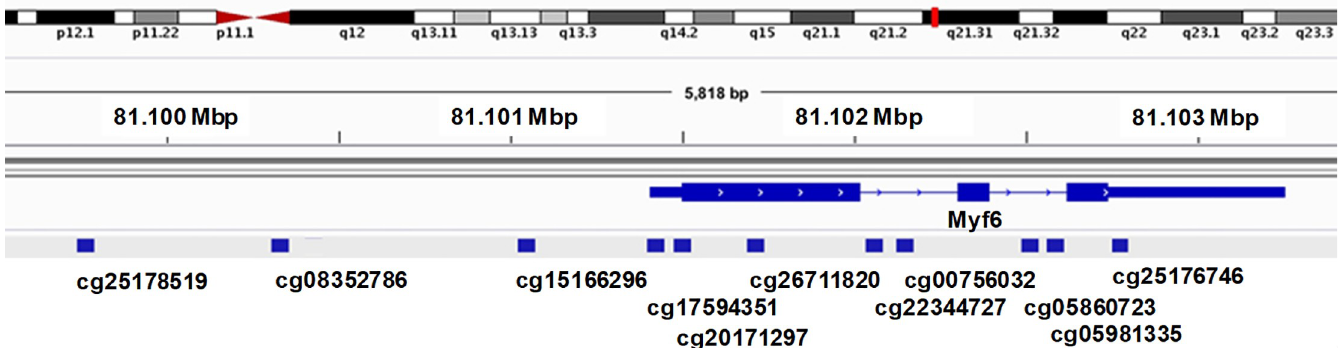
Fig 3. Locations for Myf6 methylation probe binding. Blue squares showing the binding site are situated over the ‘cg’ label of each probe. https://doi.org/10.1371/journal.pone.0227586.g003 patients with repeat post-treatment blood samples negative for MYF6 by RQ-PCR, 13 (17%) were positive by flow cytometry, at a median of 0.3 HCL cell/mm 3 . Thus, HCL cells from some patients may have lower expression of MYF6 and require more cells than others for positivity,